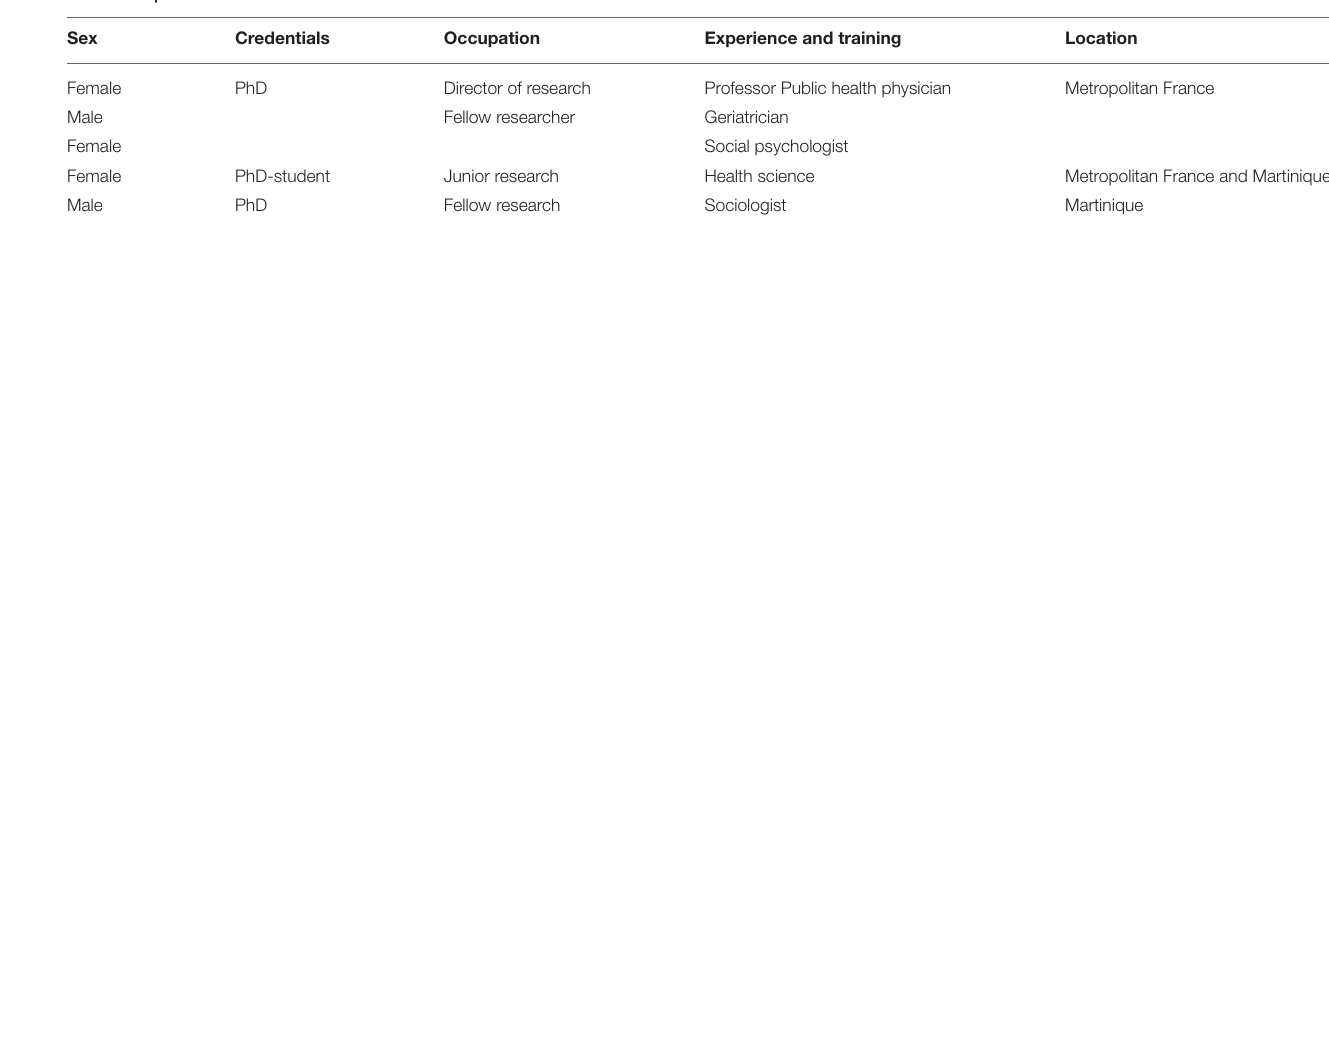
TABLE A1 | Research